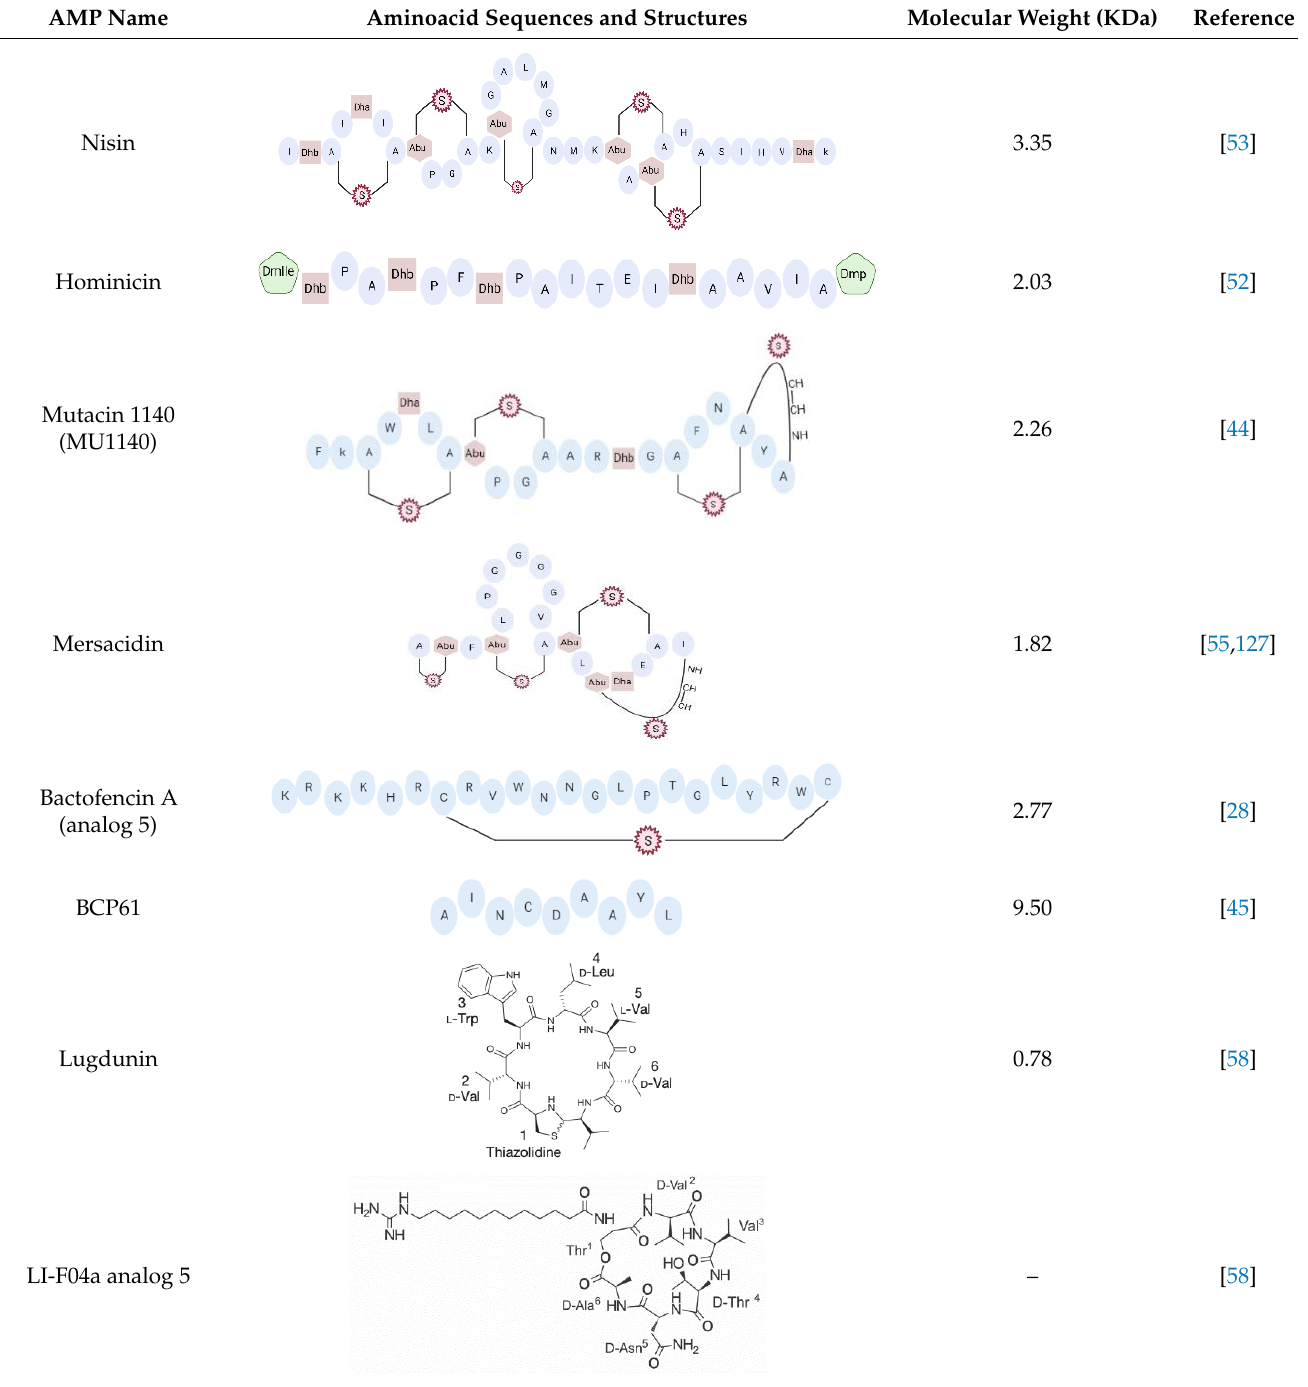
Table 6. AMPs of atypical structure derived from bacteria that showed antibacterial activity against VRSA and VISA strains.